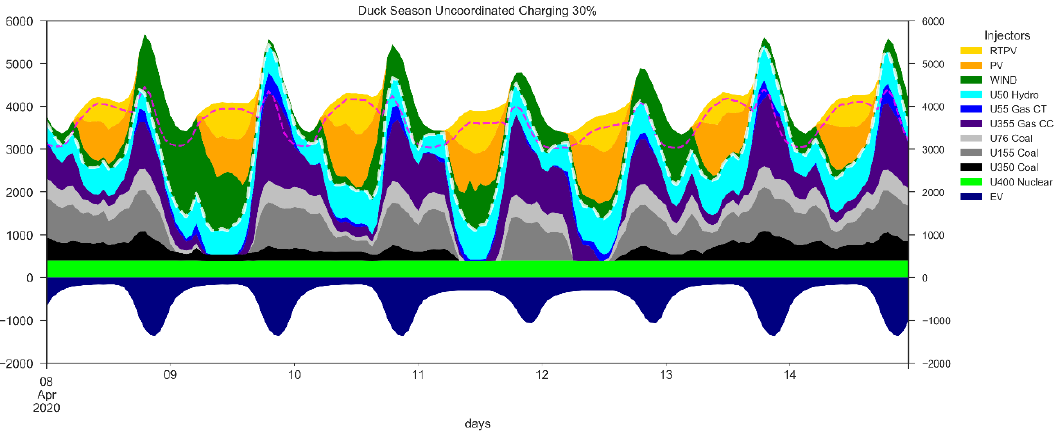
Figure 12. The generation stack for Duck week in April, assuming 30% EV penetration and uncoor- dinated EV